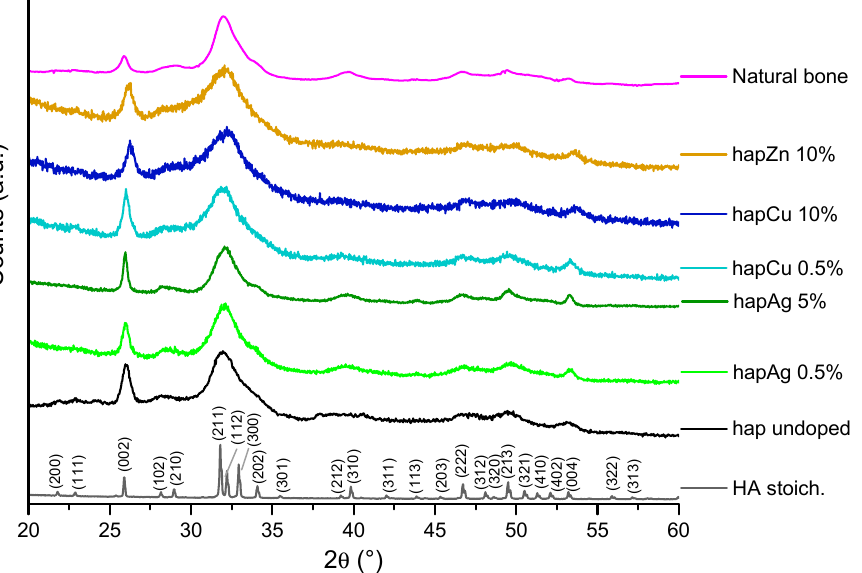
Figure 2. XRD patterns of the selected precipitated biomimetic apatite samples, as well as reference stoichiometric HA, undoped apatite and natural bone (rat, 9 months old, internal CIRIMAT collec- tion). The (hkl) indexation refers to the HA phase (PDF file # 00-009-0432).